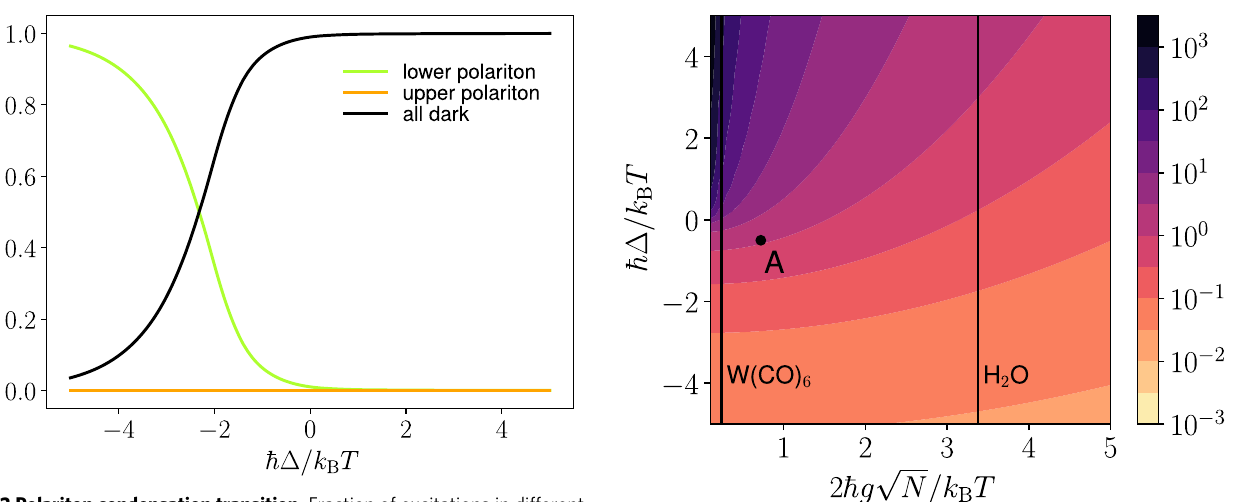
¼ 1 ∑ N where, (cid:2) n k n k is the average occupation of a dark D D k ¼ 2 N (cid:2) 1 mode, and n solvent ( E ) is the Bose – Einstein population of a solvent mode with energy E at room temperature T room 33 . The energy difference between the lower polariton and the dark state